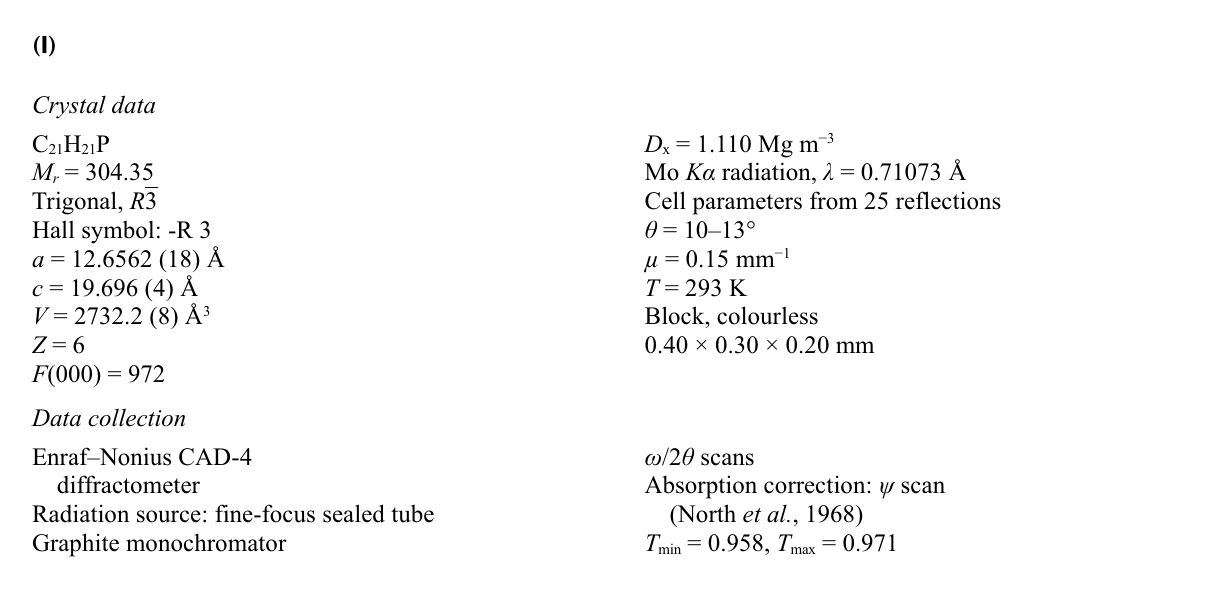
The molecular structure of the title compound, showing the atom-numbering scheme and displacement ellipsoids at the 30% probability level. Symmetry codes: (i) 1 - x + y ,1 - x , z (ii) 1 - y + 1, x - y ,